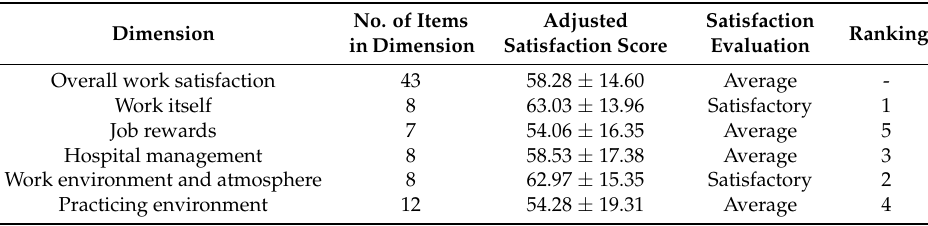
Table 2. Medical staff satisfaction and